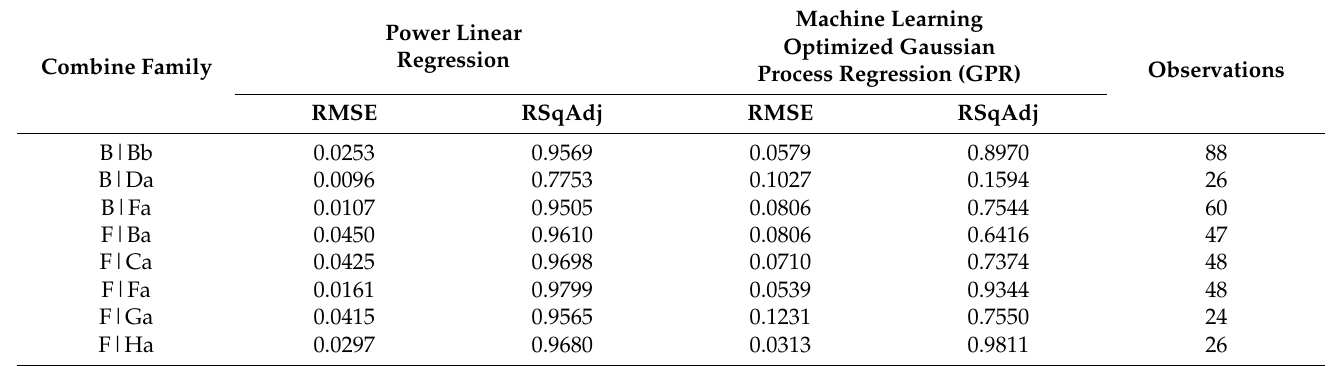
Table 5. Combine family two predictors’ parametric and nonparametric regression results.